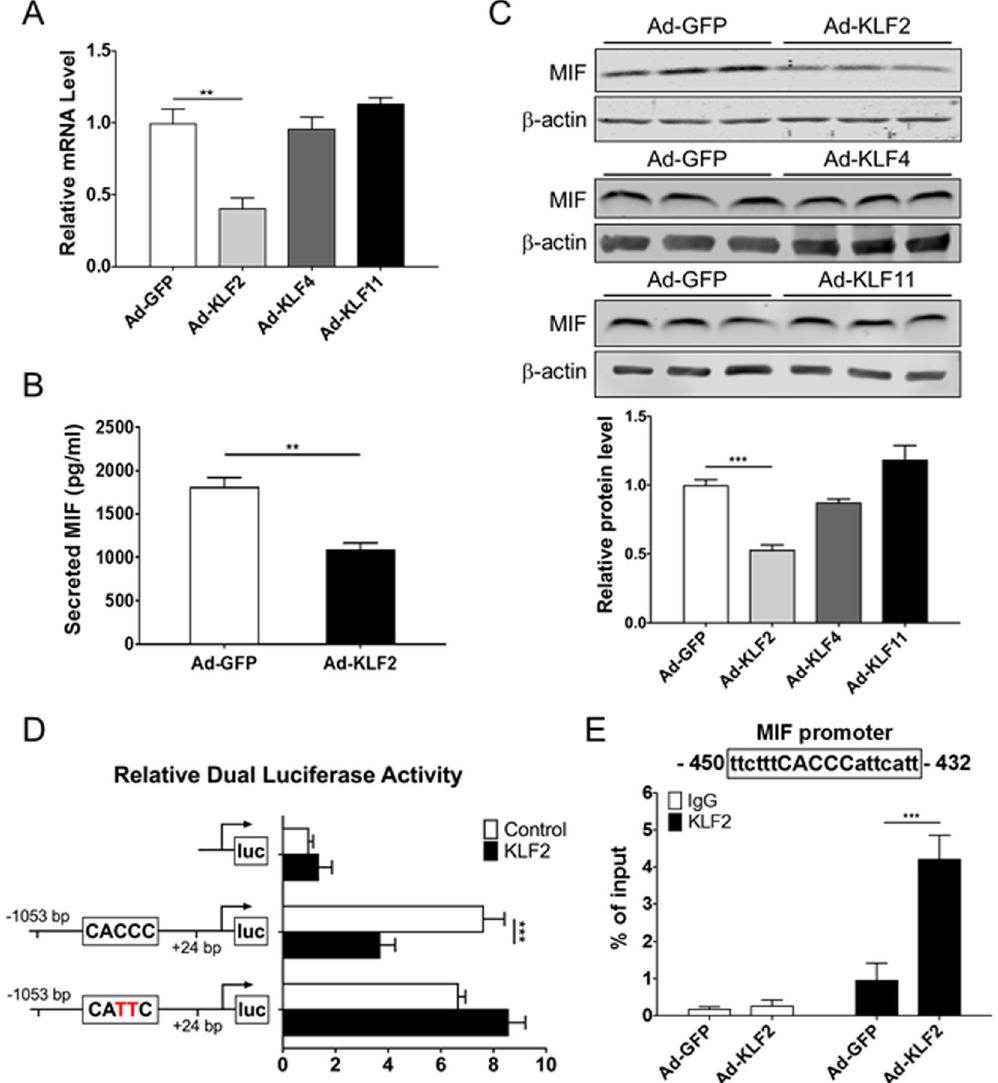
Figure 3. MIF expression is transcriptionally regulated by KLF2. ( A ) MIF mRNA level in HUVECs determined by qPCR after 48-hour adenovirus-mediated overexpression of KLF2, KLF4 and KLF11 (n = 3). mRNA expression was normalized to HPRT1 mRNA. ( B ) A total of 2 × 10 5 cells were counted and seeded into each well for the following MIF ELISA assay. HUVECs were infected with Ad-GFP, Ad-KLF2 for 2 h followed by incubation in fresh medium for 48 h. MIF secreted by HUVECs was measured by ELISA after another 48-hour incubation in serum-free medium (n = 6). ( C ) Representative Western blotting (top) and the corresponding quantitative analysis of band intensity (bottom) show the expression of intracellular MIF protein relative to the loading control β -actin in ECs overexpressing KLF2, KLF4, KLF11 or GFP (n = 3). ( D ) Dual luciferase activity was assessed in Ad293 using the 1-kB MIF promoter driven Luciferase construct and the mutated one in combination with expression plasmids for KLF2. Mutation of the indicated binding sites was performed using the Site-Directed Mutagenesis kit. Data represent relative luciferase activity (normalized to Renilla luciferase), n = 6 per group. ( E ) HUVECs were infected with adenovirus-KLF2 or -GFP for 72 hours. ChIP assay was performed using a rabbit antibody against KLF2 and equivalent amount of rabbit IgG as control. The binding of KLF2 to the MIF promoter was determined by qPCR. Data are shown as mean ± SEM. ** P < 0.01, *** P <